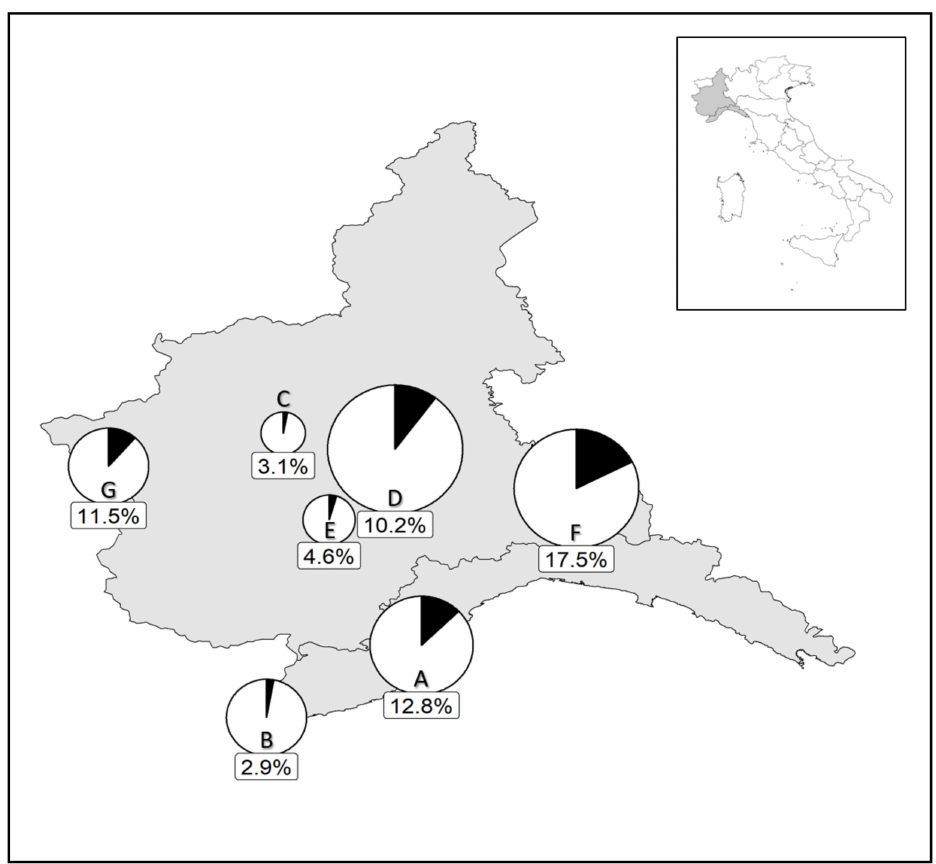
Figure 2. Percentage of Philaenus spumarius parasitized by Verrallia aucta in samples collected in northwestern Italian regions (Piemonte and Liguria) from June to October. Parasitization rates were calculated by pooling data from the dissections and molecular analyses of samples collected from 2016 to 2019. Pie chart size is a function of sample size: Arnasco-Finale Ligure ( A ), n = 172; Ventimiglia ( B ), n = 104; Chieri-Druento-Grugliasco ( C ), n = 32; Asti-Cocconato ( D ), n = 295; Cisterna d’Asti-Monteu Roero-Vezza d’Alba ( E ), n = 44; Paderna ( F ), n = 251; Cesana-Prali-Sestriere ( G ), n =